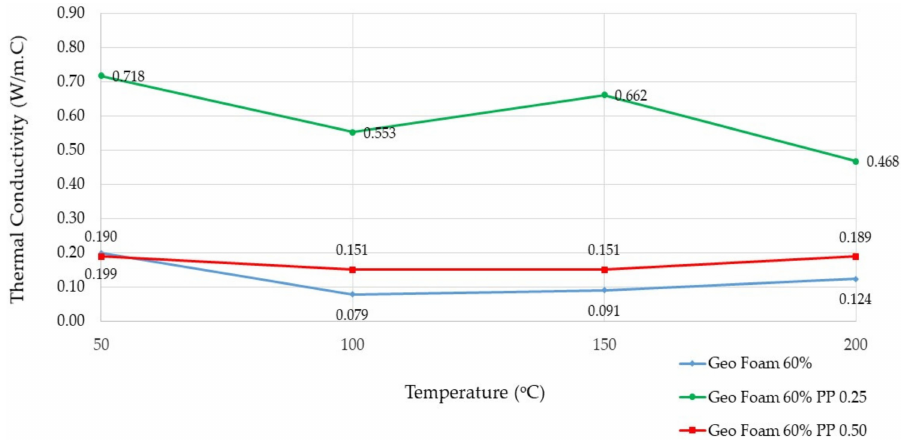
Figure 11. Thermal conductivity of 60% foamed geopolymer with varied PP